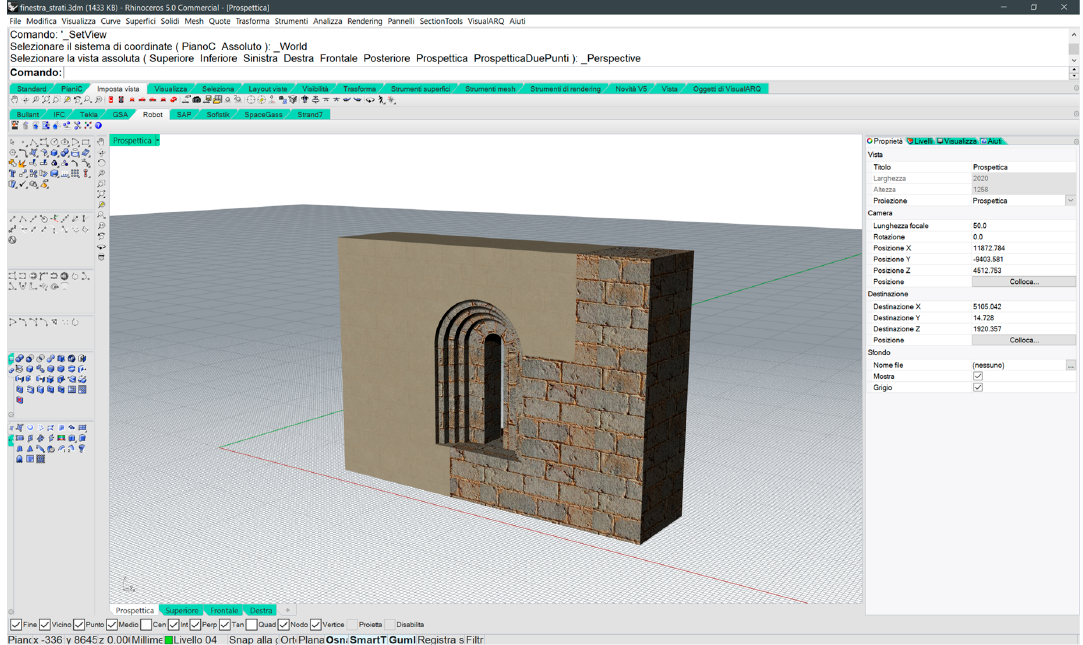
Figure 7. Simplified and conceptual 3D model (NURBS) of a medieval stone wall including plaster unit and a single-lancet window.